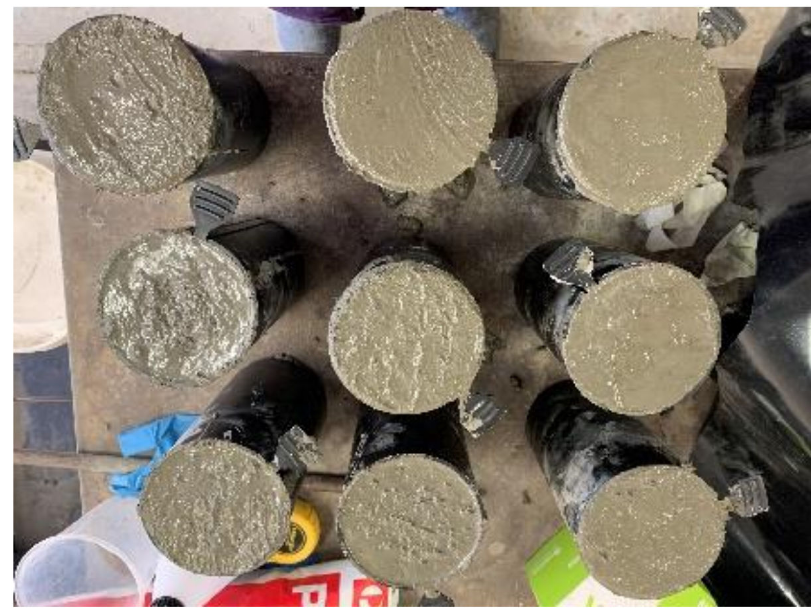
Figure 2. Freshly poured SCGC specimens.